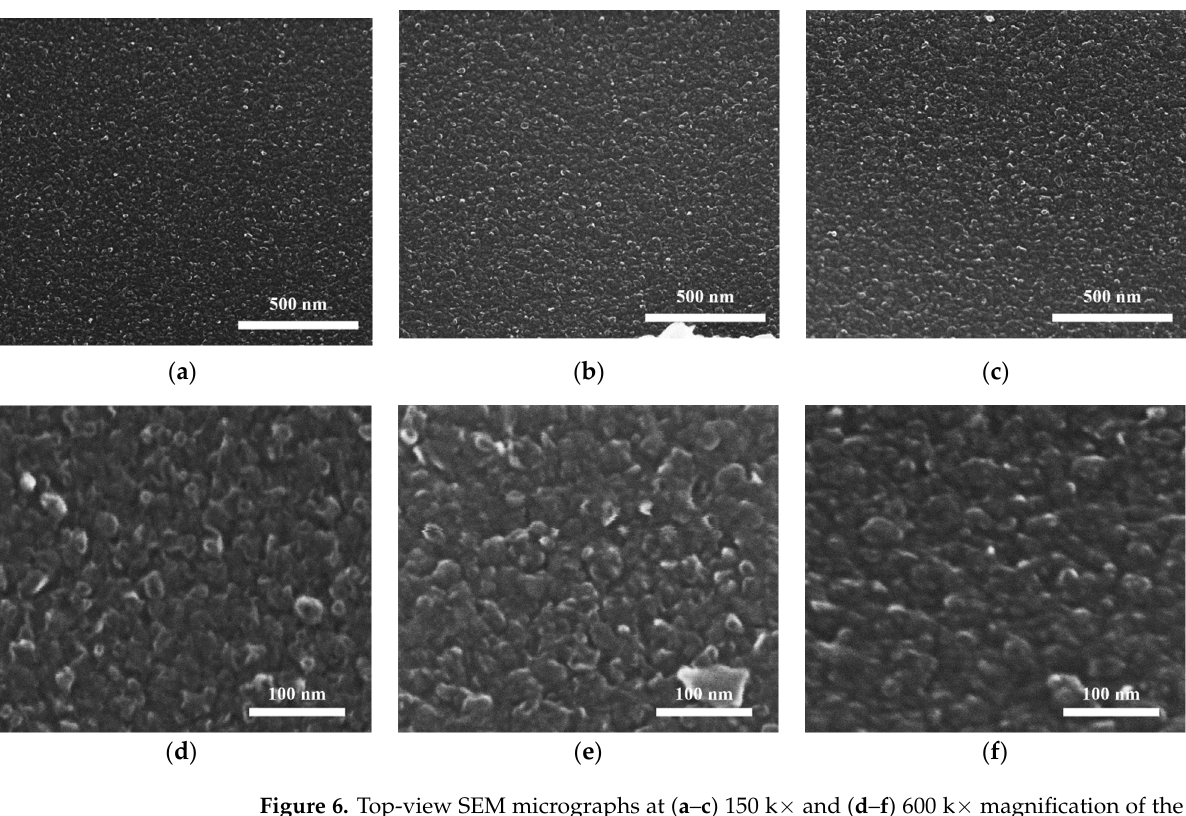
films grown for ( a , d ) 15, ( b , e ) 30, and ( c , f ) 60 min.